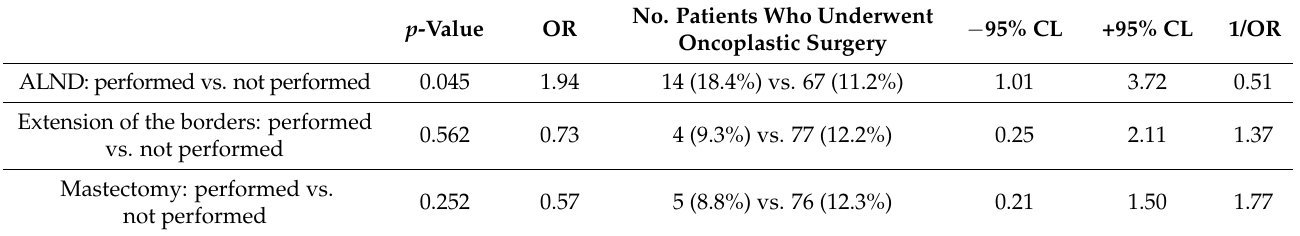
Table 6. The multivariate regression analysis on the performed oncoplastic surgery and the reoperation. No. Patients Who p -Value OR